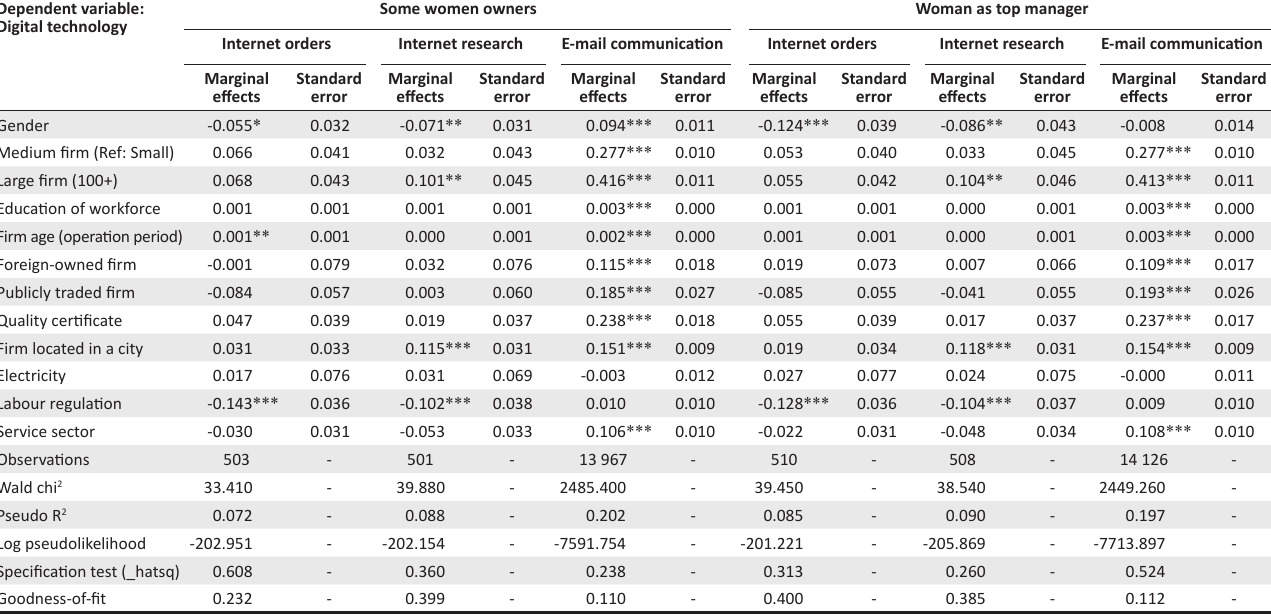
TABLE 3: Correlates of firms’ utilisation of digital technologies for business activities. Dependent variable: Digital